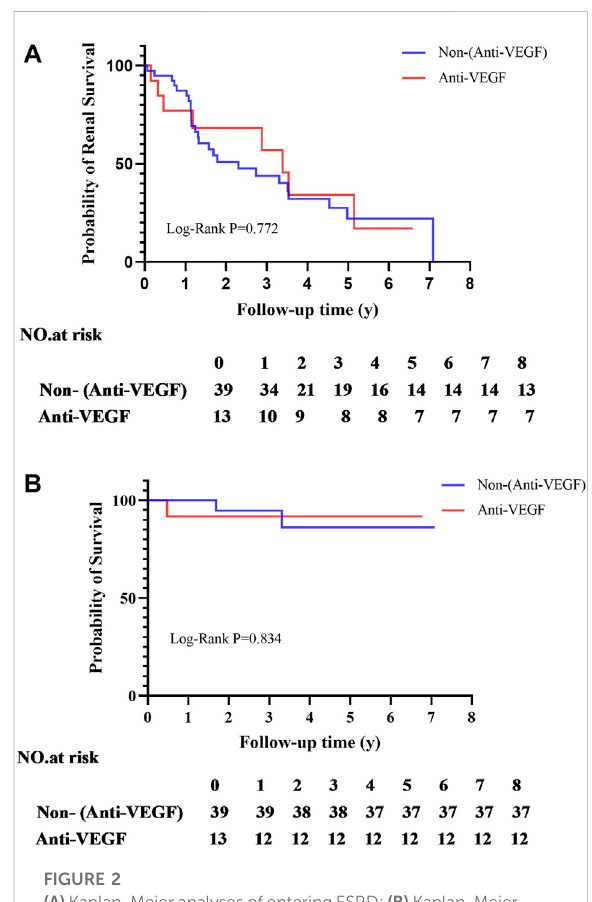
FIGURE 2 (A) Kaplan-MeieranalysesofenteringESRD; (B) Kaplan-Meier analyses of survival